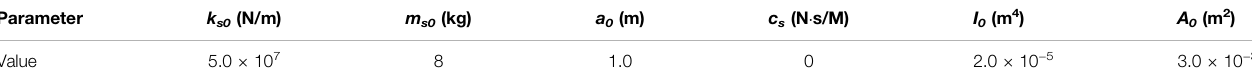
TABLE 1 | The parameters of homogeneous beam and periodic oscillators in the calculation example study, in which the subscript 0 is de fi ned to distinguish the calculation example study and parametric study. Parameter